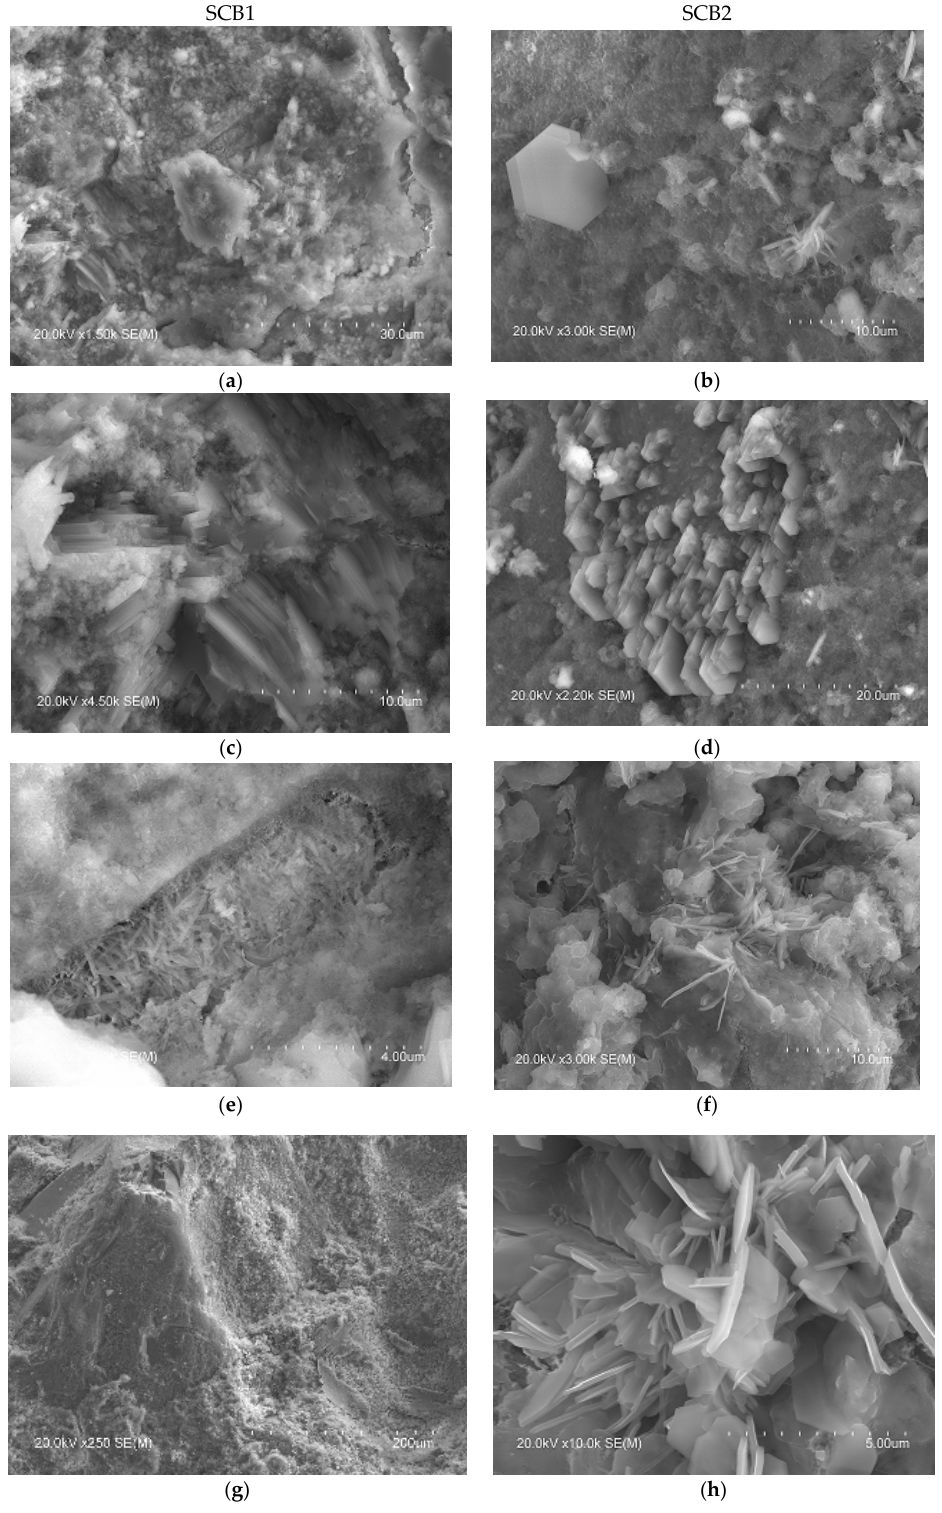
Figure 6. SEM images of the microstructure of the hydrated SCBs at 28 days. Main phases: Left: SCB1: ( a ) portlandite and e tt ringite, ( c ) portlandite, ( e ) e tt ringite, ( g ) unhydrated MSWI FA grains; SCB1: ( a ) portlandite and ettringite, ( c ) portlandite, ( e ) ettringite, ( g ) unhydrated MSWI FA grains; right: SCB2: ( b ) portlandite and C-S-H, ( d ) portlandite, ( f ) e tt ringite and Friedel’s salt, ( h ) e tt ringite right: SCB2: ( b ) portlandite and C-S-H, ( d ) portlandite, ( f ) ettringite and Friedel’s salt, ( h ) ettringite and Friedel’s salt. and Friedel’s